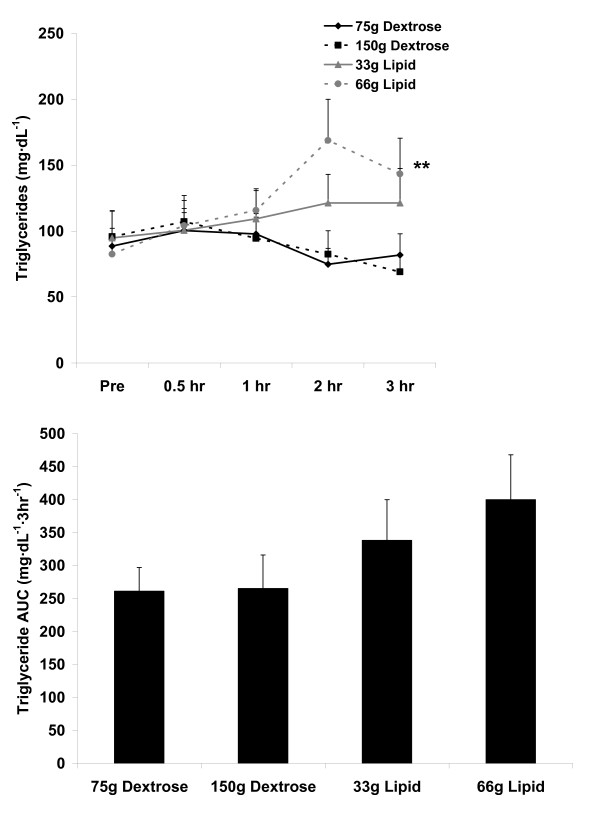
Blood triglycerides before and following the consumption of a dextrose or lipid meal in young healthy men. Data are mean ± SEM. **Meal effect (p = 0.01); 66 g Lipid > 75 g Dextrose and 150 g Dextrose. Time effect (p = 0.63). Meal × Time effect (p = 0.27). AUC effect (p = 0.26).